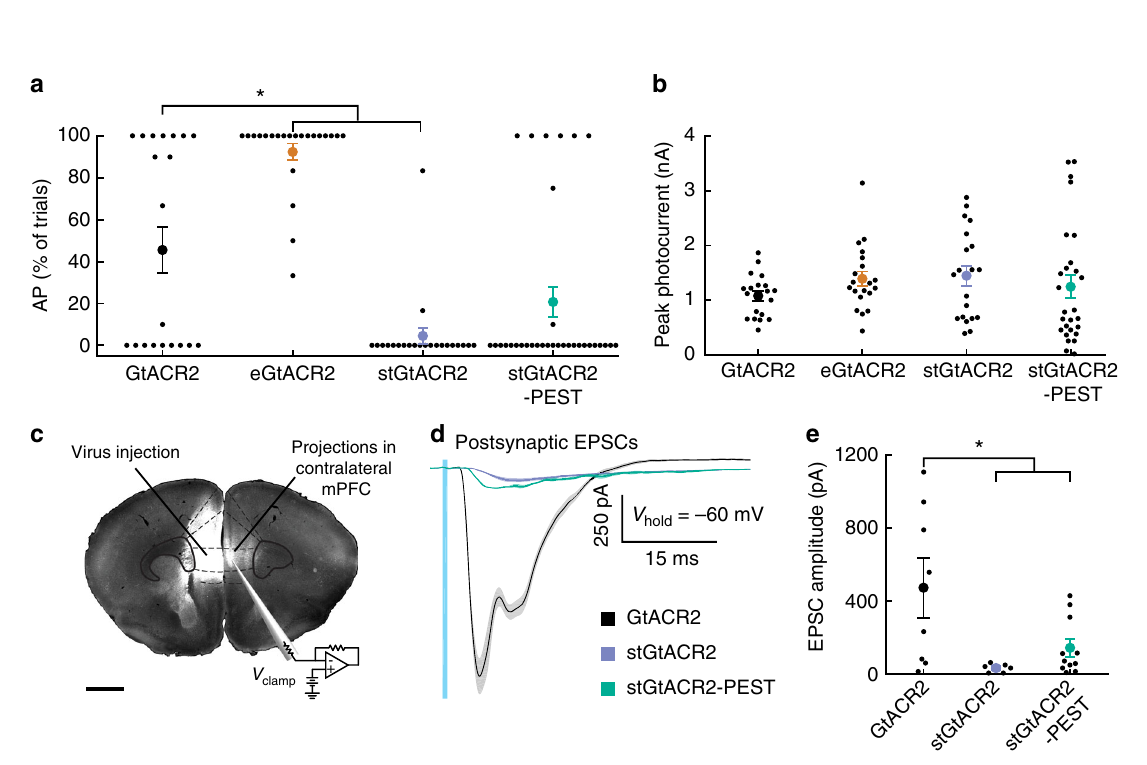
Fig. 3 Targeting GtACR2 to the neuronal soma leads to enhanced photocurrent amplitude. a Schematic of different targeting approaches. GtACR2 transmembrane helix con fi guration based on C1C2 crystal structure 67 . b Image showing the fl uorescence resulting from AAV-mediated cytosolic fl uorophore expression in the mPFC. Transduction is most dense at the injection site (indicated by the lower dashed box) and sparse along the injection needle track (upper dashed box). Schematic adapted with permission from 68 . Scale bar, 1 mm. c – e Higher magni fi cation images of the areas indicated in b . c Magni fi ed images of the injection site. Scale bar, 250 µ m. d Magni fi ed images of the more dorsal region of sparse expression. Scale bar, 250 µ m. e Higher magni fi cation of d . stGtACR2 and stGtACR2-PEST show enrichment at the soma. Scale bar, 50 µ m. f Quanti fi cation of soma restriction by normalizing mPFC layer 1 fl uorescence by the mean fl uorescence measured at the injection center. Targeting reduces relative layer 1 fl uorescence (GtACR2: n = 2; all other groups: n = 4). g Light power density dependence of stationary photocurrents in whole-cell patch-clamp recordings of neurons in acute brain slices. Inset: Representative whole-cell voltage-clamp recording. The stationary photocurrent was de fi ned as the photocurrent at the end of a 1 s light pulse. The photocurrent fi t ( I (LPD) = I max *LPD* (EPD50 + LPD)) − 1 was performed per cell with the effective light power density (LPD) for 50% photocurrent (EPD50) as free parameter. stGtACR2 and stGtACR2-PEST had a signi fi cantly higher maximal stationary photocurrent than GtACR2 (ANOVA, F (2,23) = 11.84, p = 2.9*10 − 4 ; GtACR2: n = 8, stGtACR2: n = 10, stGtACR2-PEST: n = 8). Fits to previously-published peak photocurrents for eArch3.0 and eNpHR3.0 are shown for reference (with permission from 8 ). Results are presented as mean ± SEM